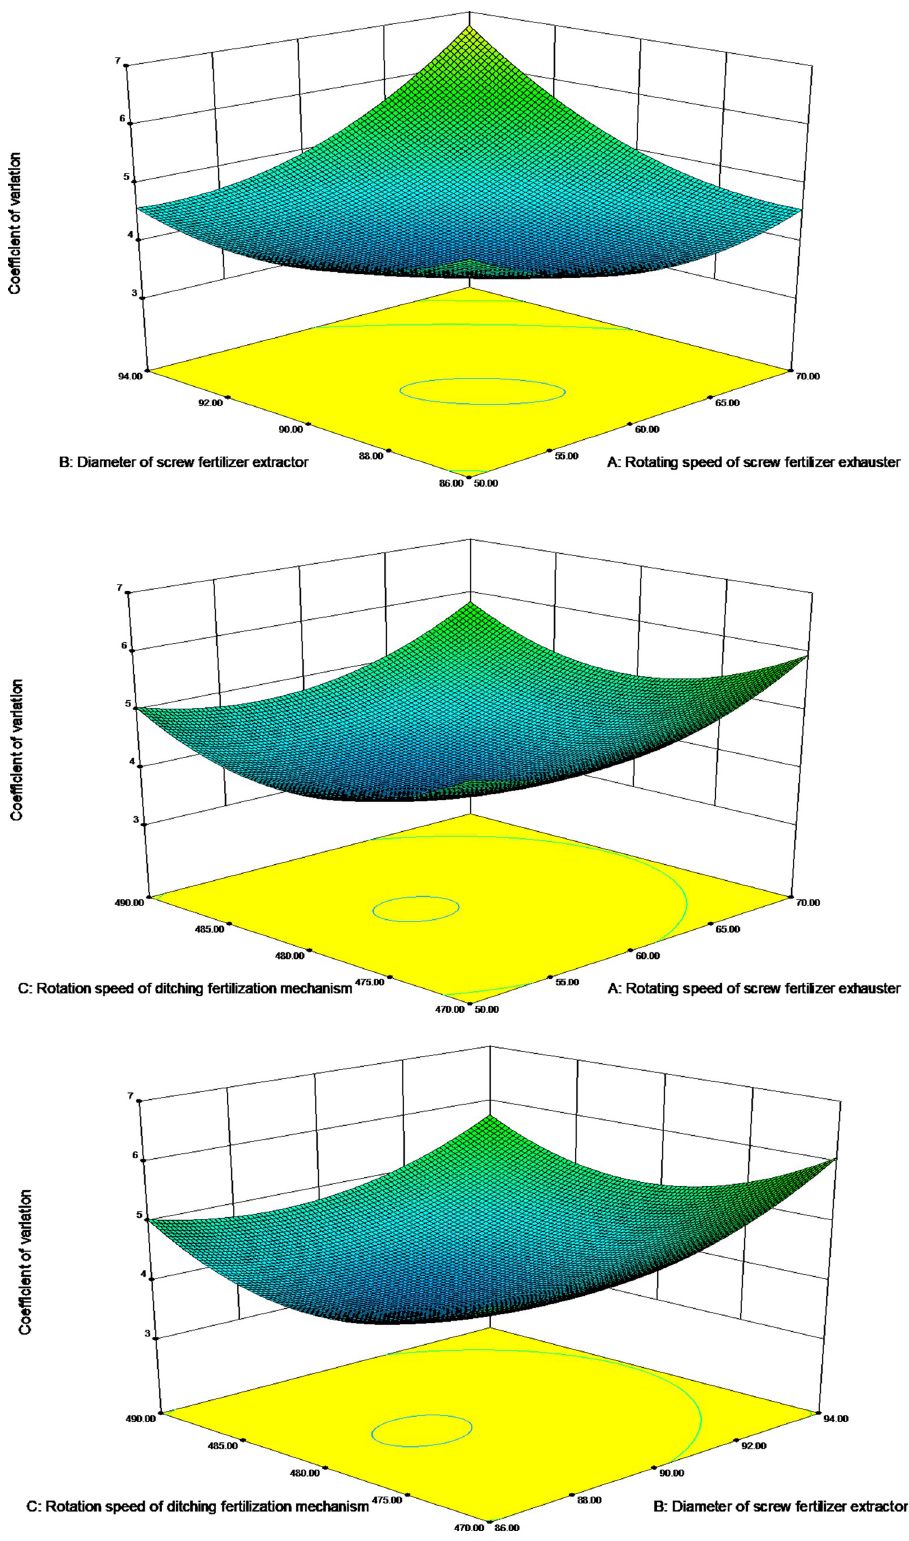
Fig 8. Response surface for the effect of each factor on the coefficient of variation. (a) Open trenching and fertilizing mechanism at 480 r/min; (b) Spiral fertilizer discharge at 90 mm diameter; (c) Spiral fertilizer discharge at 60